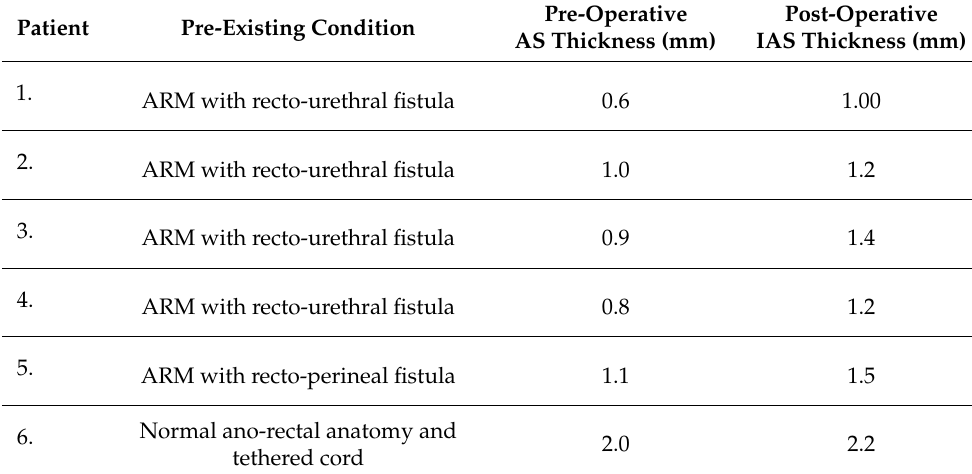
Table 4. Internal anal sphincter thickness (mm) measured with ultrasound pre-operatively and 6 months after the last treatment with echo-assisted lipofilling in our six incontinent